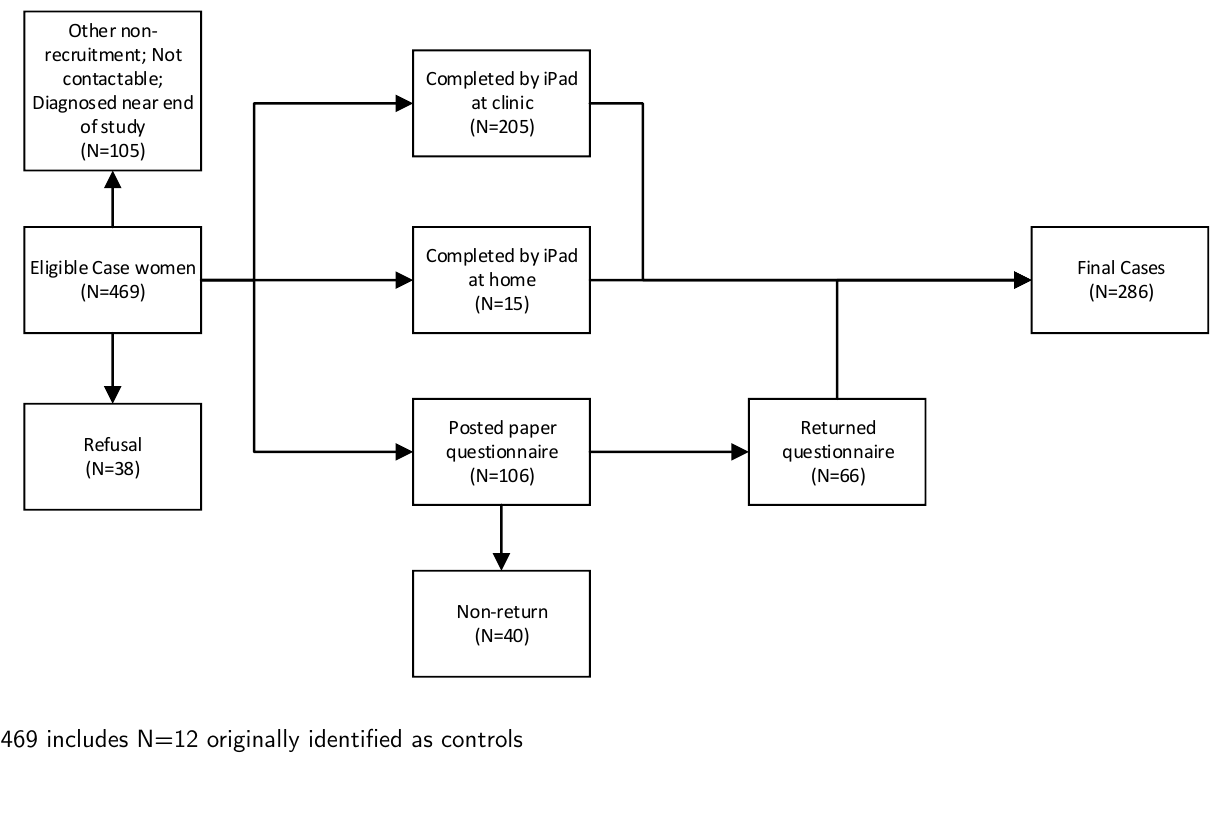
Figure 1a: Flow diagram of recruitment for cases